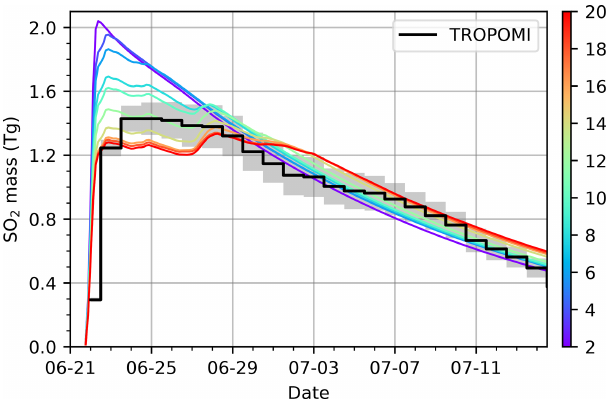
Figure 8. Temporal change of SO 2 total mass in MPTRAC for- ward simulations, which were initialized by considering different numbers of days of TROPOMI observations since the beginning of the Raikoke eruption (see color bar). Total mass of SO 2 injection in all simulations is 2.1Tg. In the forward simulations, the mass is derived from the chemistry module. The mass changes measured by TROPOMI are shown by the black line, and gray shading indicates the measurement errors.